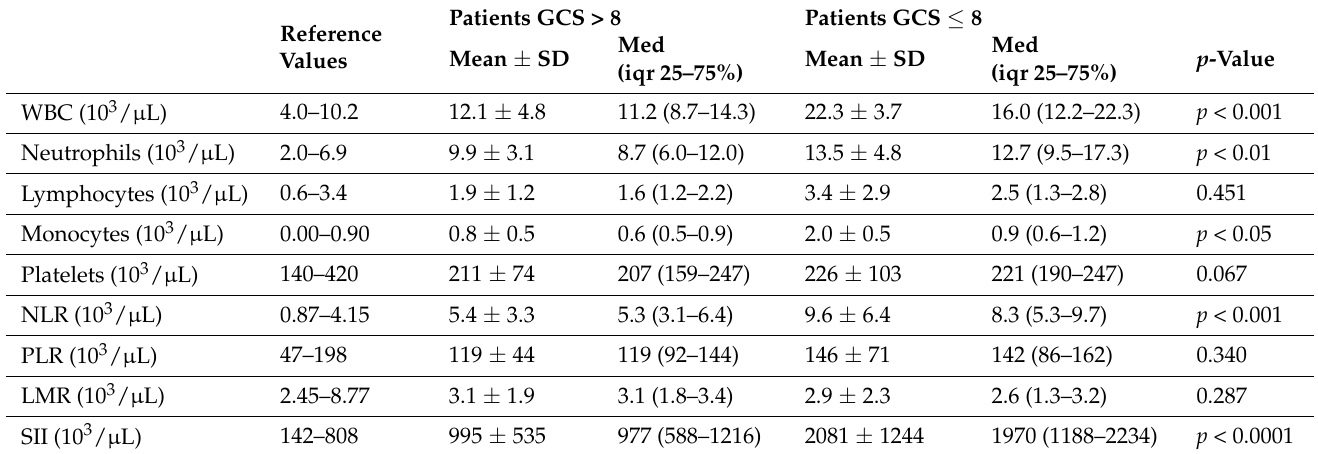
Table 3. White blood cells and platelets counts.